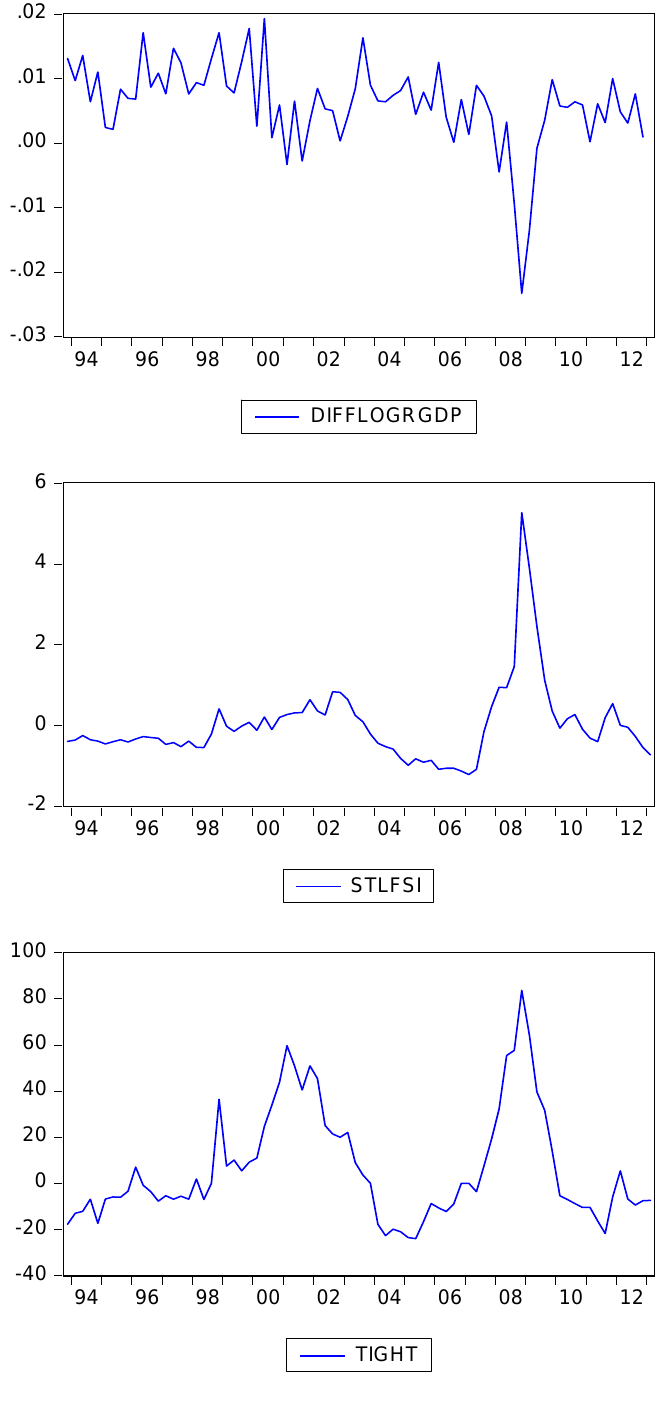
Figure 1. Time series graphs of the endogenous variables over the sample 1993Q4-2013Q1. DIFFLOGRGDP is the log difference of real GDP for the U.S. STLFSI is the St. Louis Fed stress indicator, and TIGHT is the percentage of loans officer reporting a tightening of standards.